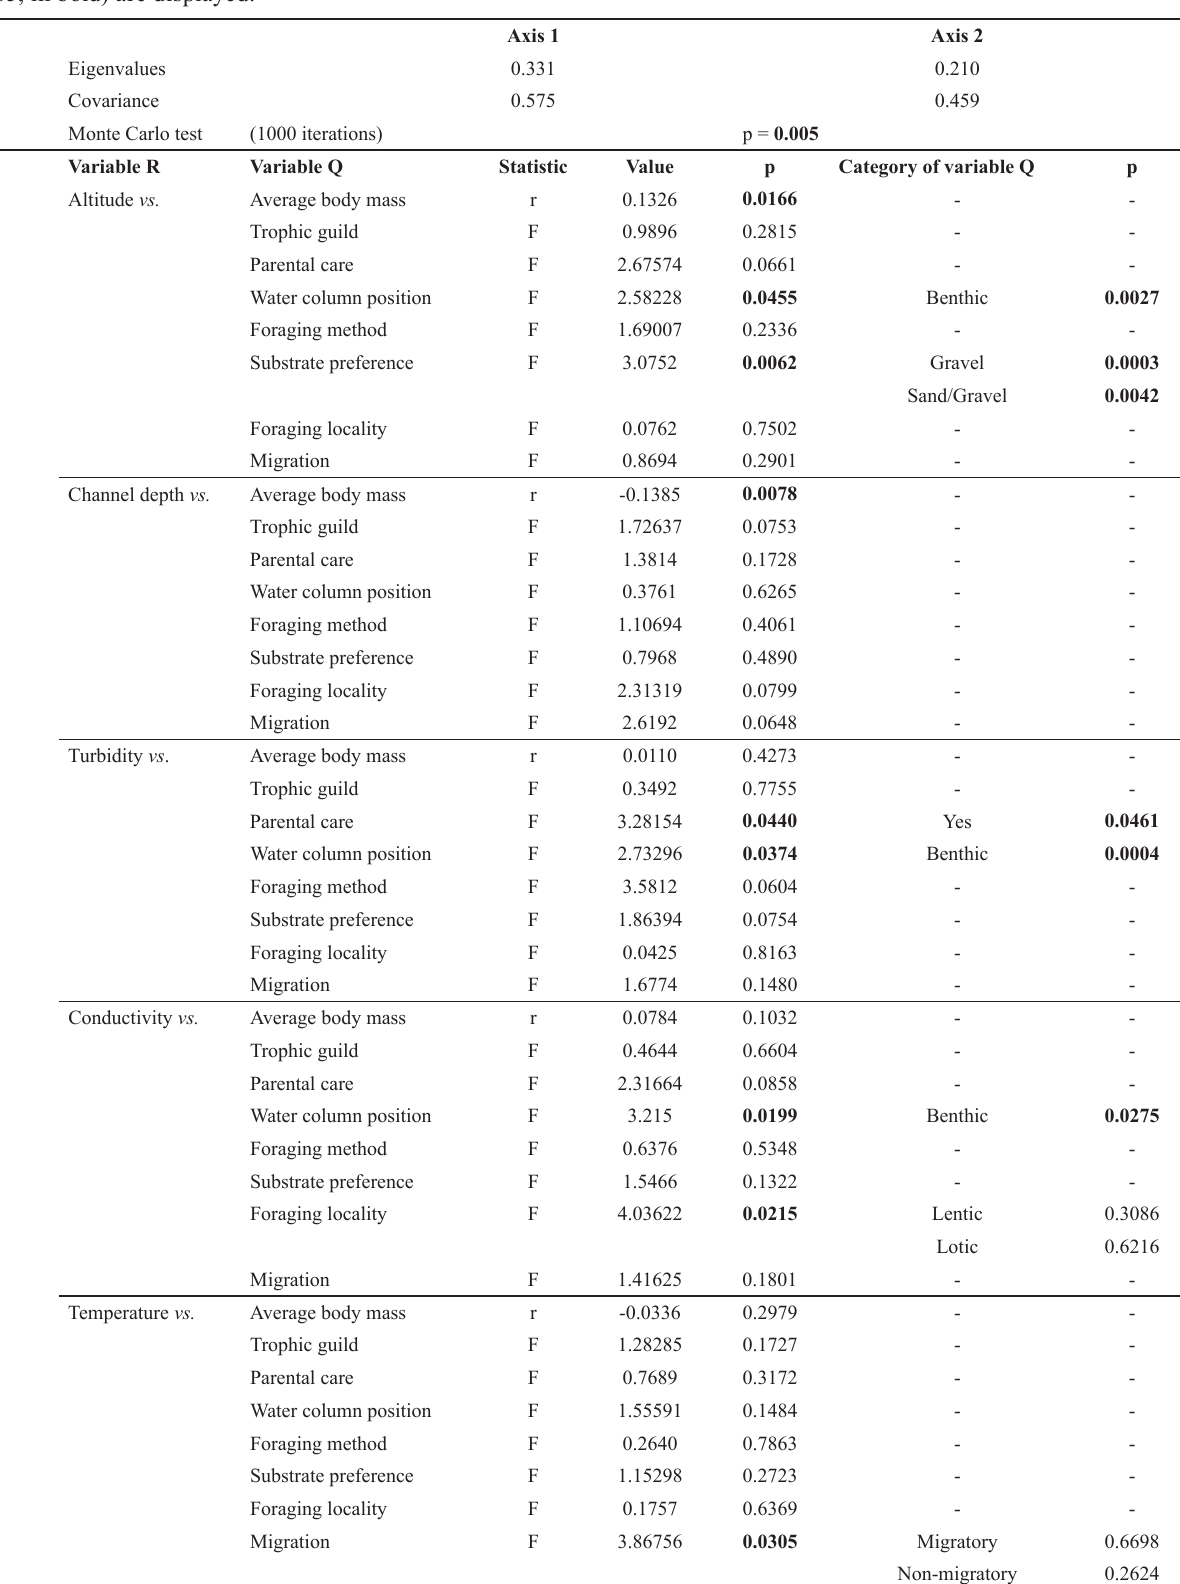
Table 3 . Results of the RLQ (A) and fourth-corner (B) analyses of environmental variables (variable R) and fish functional traits (variable Q) from 25 headwater streams of Araguaia and Tocantins river basins. Only results with significant values (p<0.05; in bold) are